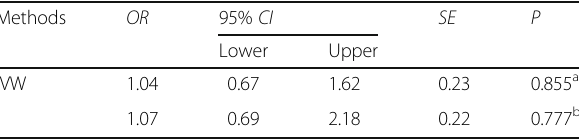
Table 4 The Mendelian randomization analysis of hs-CRP with CHD